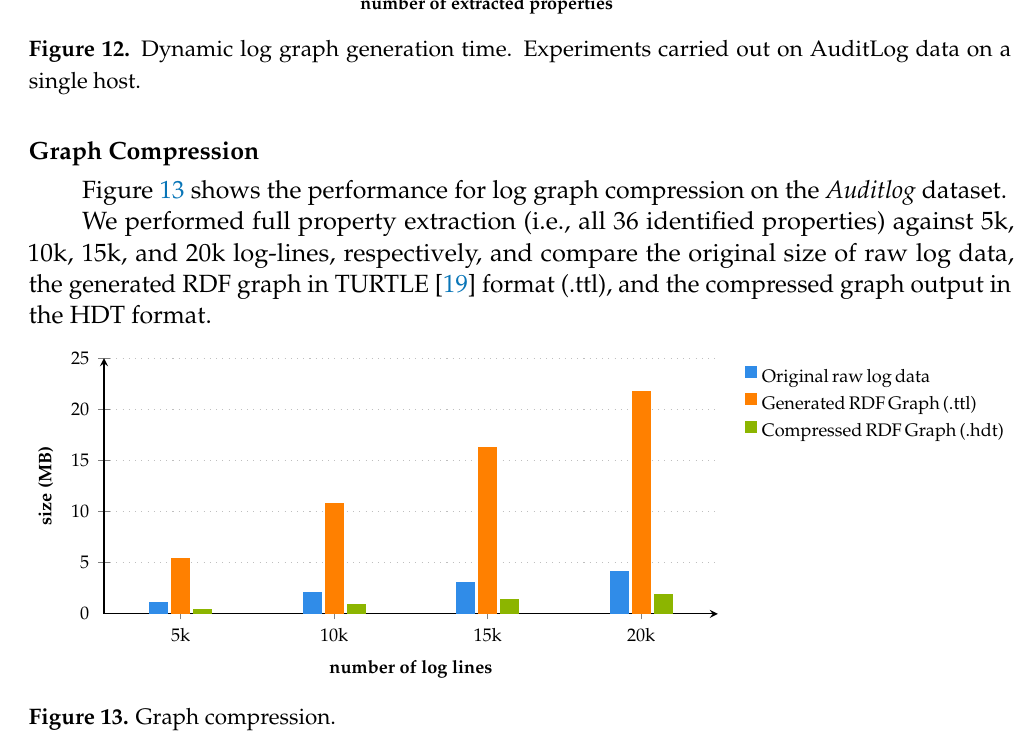
Figure 12. Dynamic log graph generation time. Experiments carried out on AuditLog data on a single host.